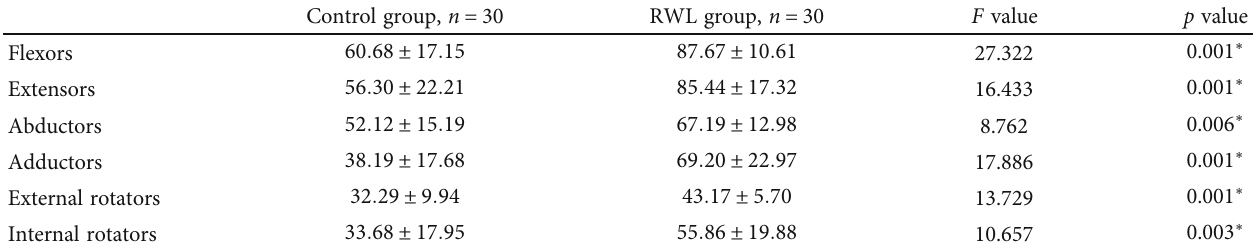
Table 2: Data analysis of shoulder muscles normalized concentric peak torques (N.m) at 120 ° /sec.